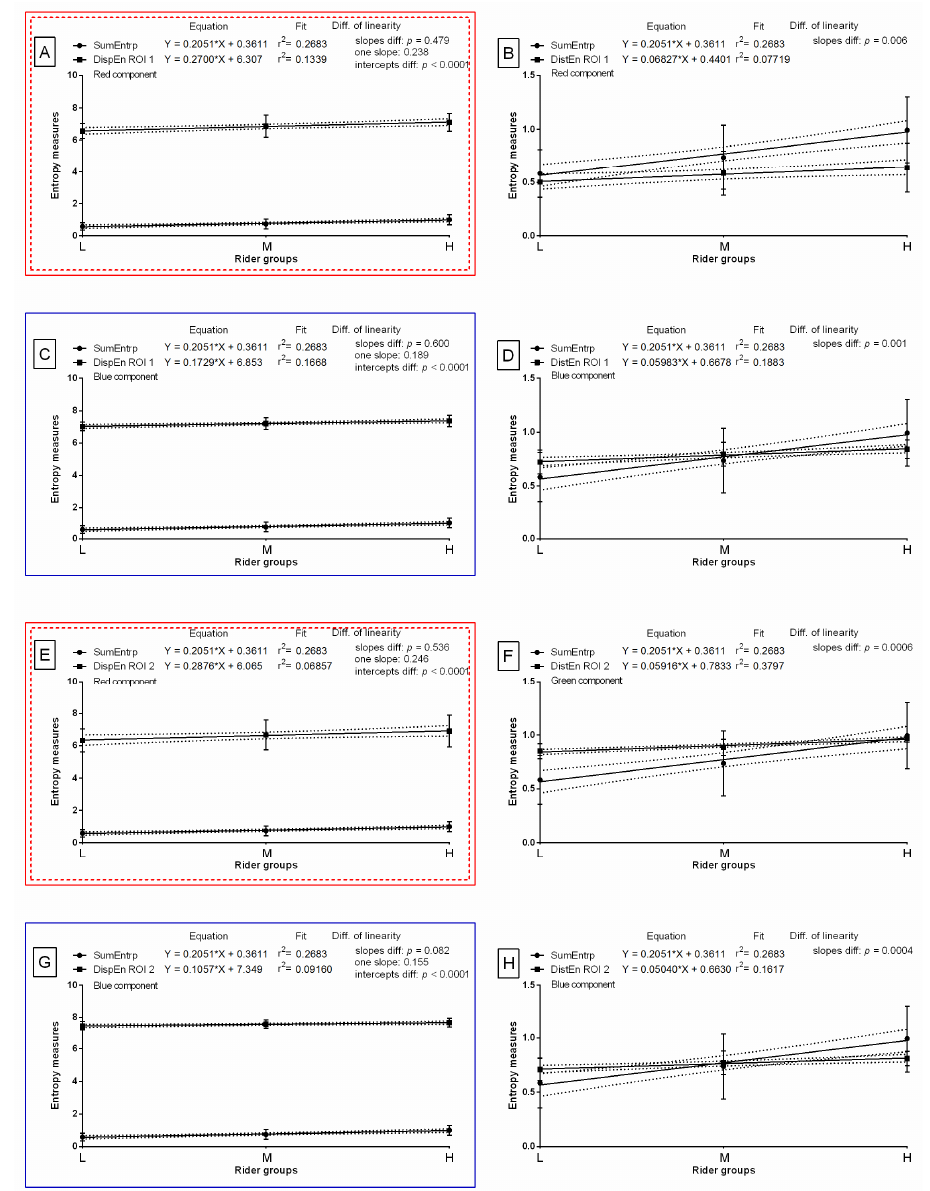
Figure 7. Comparison of studied entropy measures (DispEn—two-dimensional dispersion entropy, DistEn—two-dimensional distribution entropy) and selected gray-level run-length matrix feature (SumEntrp—summation entropy) for examined color components (red, ( A , B , E ); green, ( F ); blue, ( C , D , G , H )), which were found to be significantly different between light (L), moderate (M), and heavy (H) rider groups on the post-exercise imaging. Data were presented separately for the withers area (ROI 1) ( A – D ) and the thoracic spine area (ROI 2) ( E – H ). Similarity was tested using linear regressions. A p -value of less than 0.05 was considered significant. If the difference between slopes was not significant, a single slope measurement was calculated. Plots with the entropy measures and slopes that did not differ with SumEntrp were marked by colored (red, blue) solid frames. Plots with the entropy measures and slope values that were higher than SumEntrp were marked by colored (red, blue) dashed